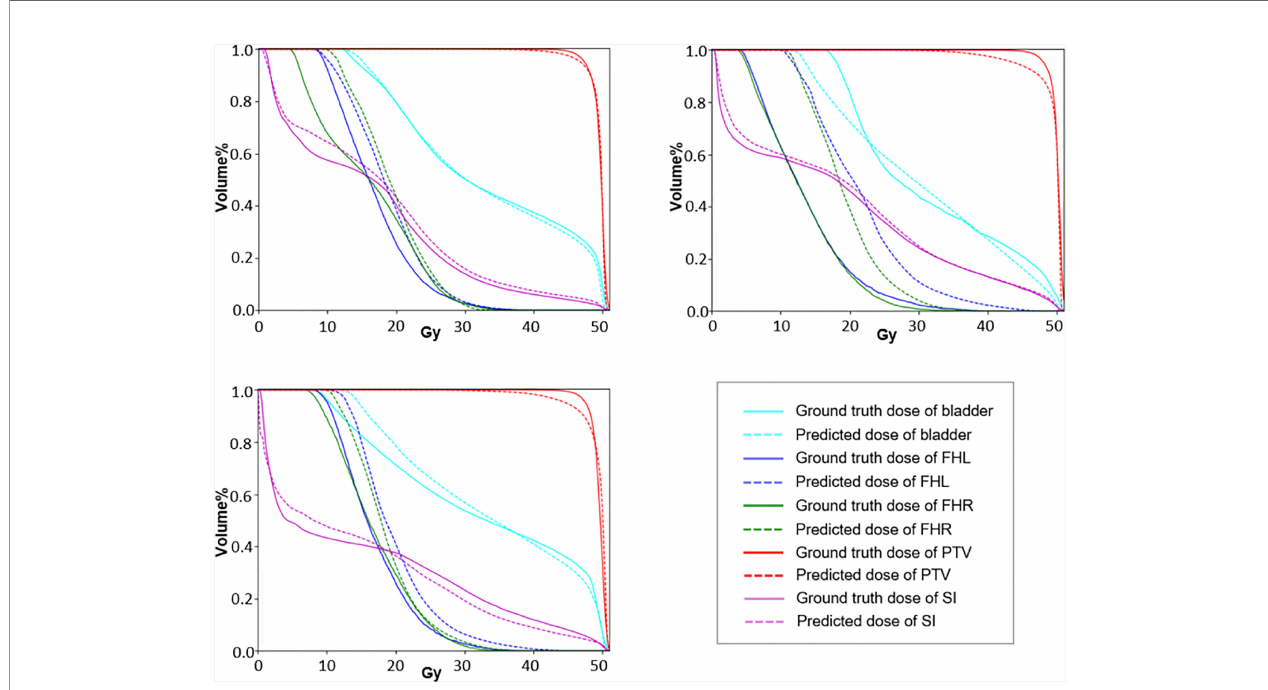
FIGURE 4 | The DVH curves of three typical predictions. The dotted lines represent the prediction results and the solid lines represent the approved